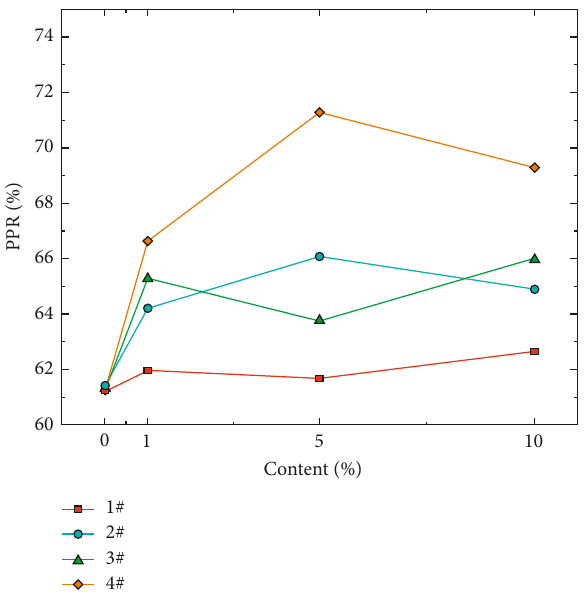
Figure 4: PPR of different types of asphalt.